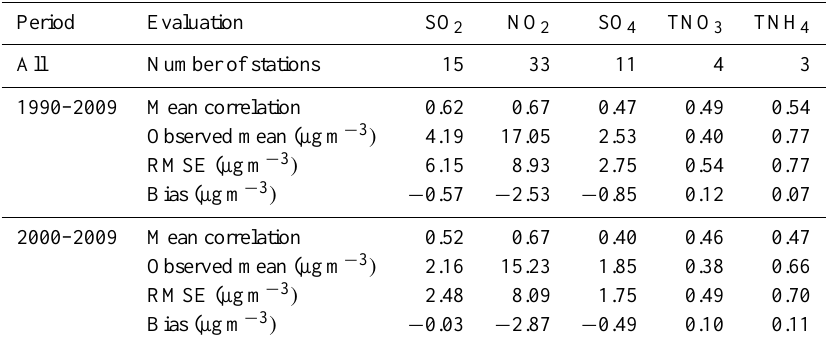
Table 5. Statistical comparison between measured and modelled concentrations using daily observations at those stations that passed the se- lection criteria presented in Sect. 2.2.1 for the 1990–2009 and 2000–2009 time periods. The number of considered stations, mean correlation, observed mean, RMSE and bias are given for each